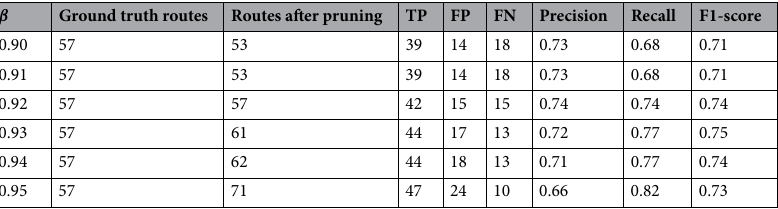
Table 2. Results for the triangle inequality pruned graph in the border region between Germany and Austria with 23 locations.